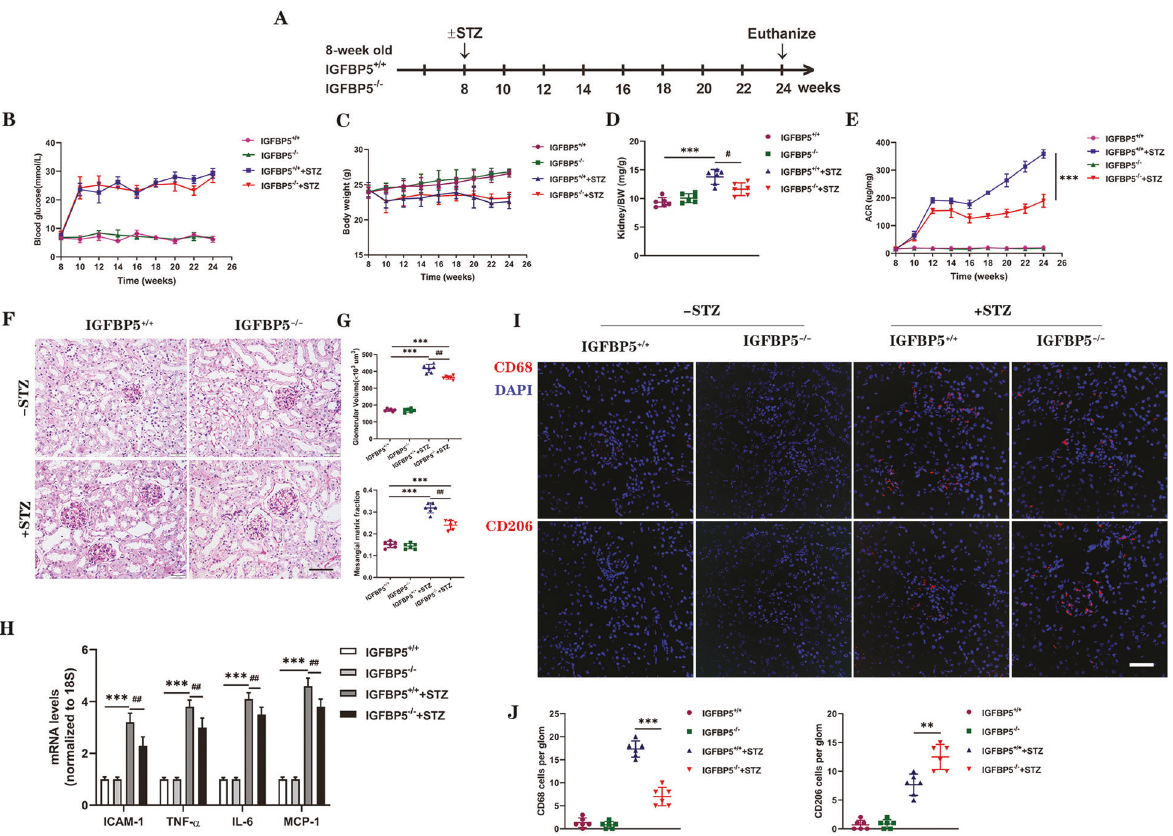
Fig. 2 IGFBP5 ablation protects against diabetic glomerulopathy. A Schematic showing the experimental design. STZ or citrate buffer vehicle was injected into 8-week-old IGFBP5 + / + and IGFBP5 − / − mice. The mice were euthanized at 16 weeks postinjection for analysis. n = 6 mice. B , C Biweekly blood glucose and body weight measurements of control and diabetic mice. D Kidney to-body weight (BW) ratio at 16 weeks after DM induction. E Urinary albumin-to-creatinine ratio (ACR) over time; n = 6 mice. F Representative images of periodic acid-Schiff (PAS)-stained kidneys. Scale bar, 50 μ m. G Quanti fi cation of glomerular volume and mesangial matrix fraction per mouse; n = 6 mice. H RT – PCR analysis of the mRNA levels of ICAM-1, TNF- α , IL-6, and MCP-1 in control and diabetic mice. n = 6 mice. I Representative images of CD68